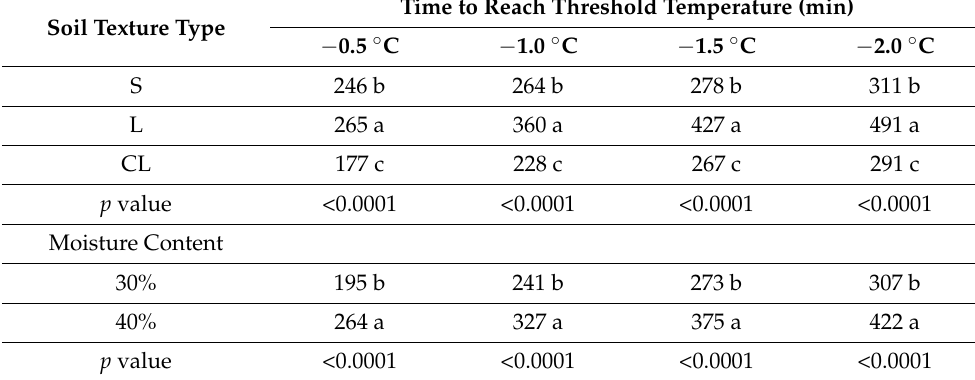
Table 3. Time (in minutes) it took for each soil type and moisture content to reach defined threshold values of − 0.5 ◦ C, − 1.0 ◦ C, − 1.5 ◦ C, or − 2.0 ◦ C from an ambient temperature of 15 ◦ C. Means are averaged within soil type or moisture content. Moisture content refers to 30% or 40% of water holding capacity. Mean comparison is valid within columns. Means followed by different letters are statistically significant at p < 0.05. Abbreviations: S, Sand; L, Loam; CL, Llay